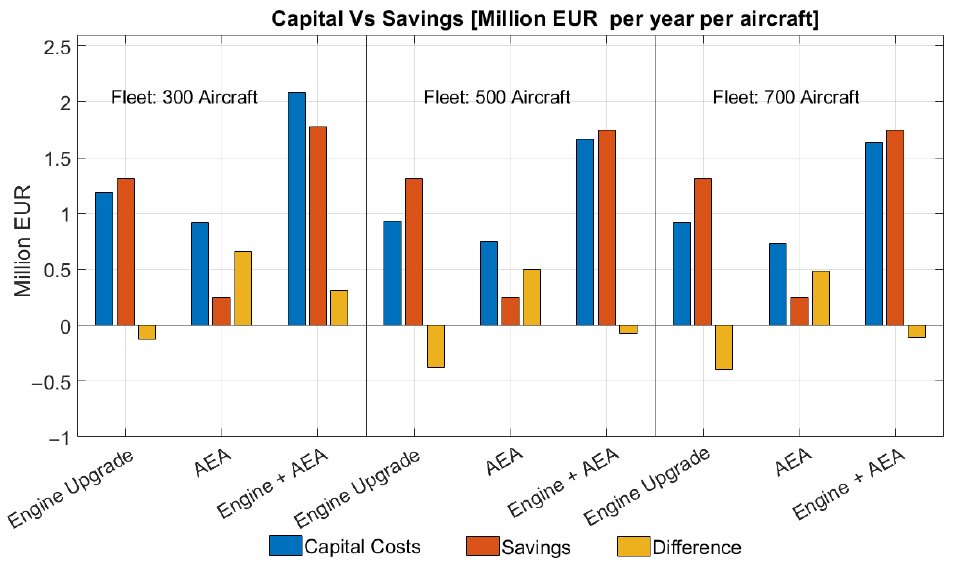
Figure 13. Capital costs and savings and their difference per year per aircraft. The noise taxes considered for the baseline are increased by 75%, as taken from Figure 11.